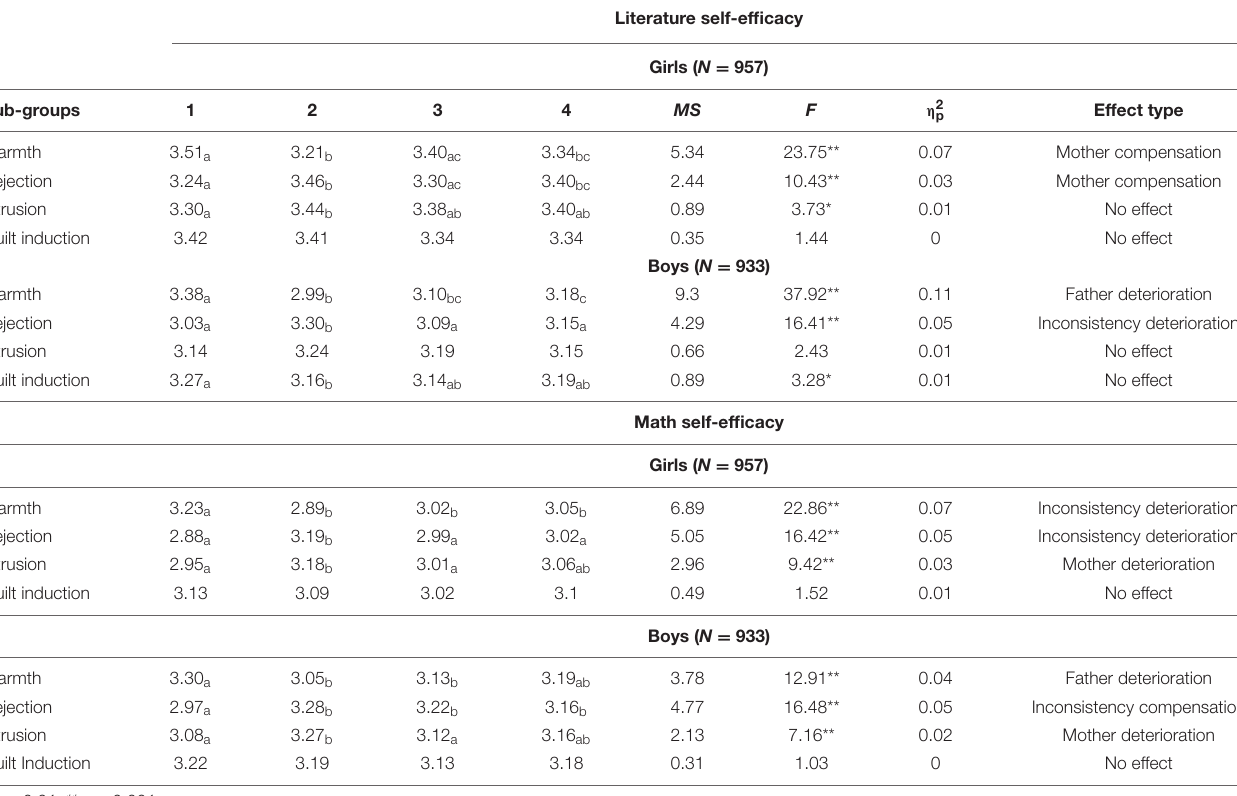
TABLE 3 | Literature and math self-efficacy scores of girls and boys across the four groups of co-parenting (in)consistency.